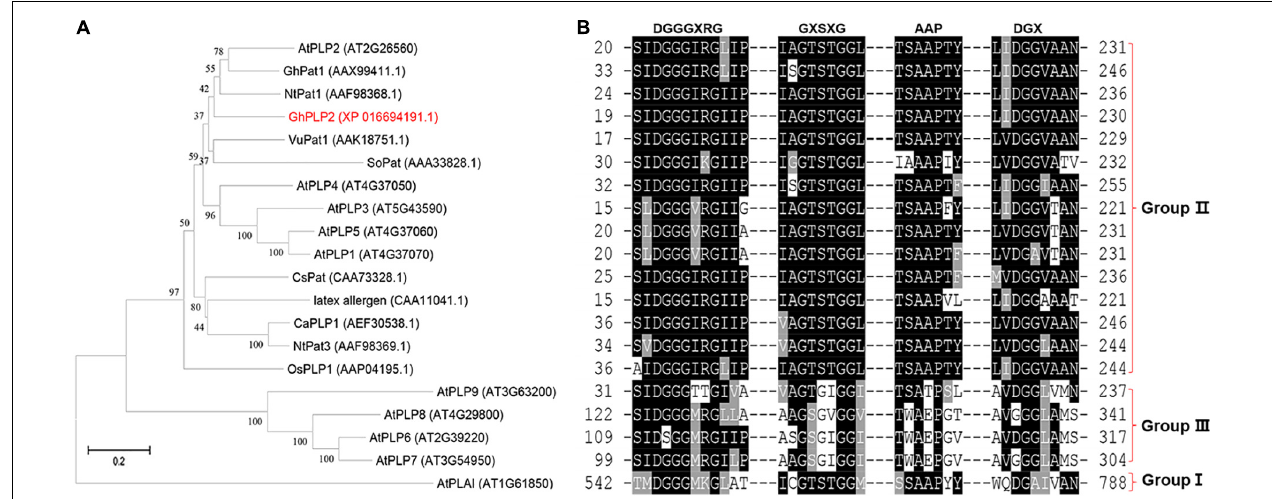
FIGURE 1 | Sequence analyses of GhPLP2 and other patatin-like proteins. (A) Phylogenetic analysis of GhPLP2 and other plant patatin-like proteins. At1g61850 (AtPLAI) was used as the outgroup. The numbers on the tree represent bootstrap scores. (B) Alignment of the conserved motifs of patatin-like proteins. Esterase box GxSxG and residues DGX constitute the S-D catalytic dyad. Anion binding element: DGGGxxG and proline motif: APP.